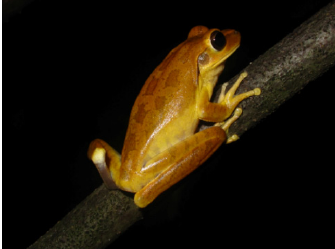
Figure 1. Adult specimen of Boana raniceps . Photo courtesy by Prof. Dr. Pedro Ivo Simões (Pernam- buco Federal University, Recife, Brazil).